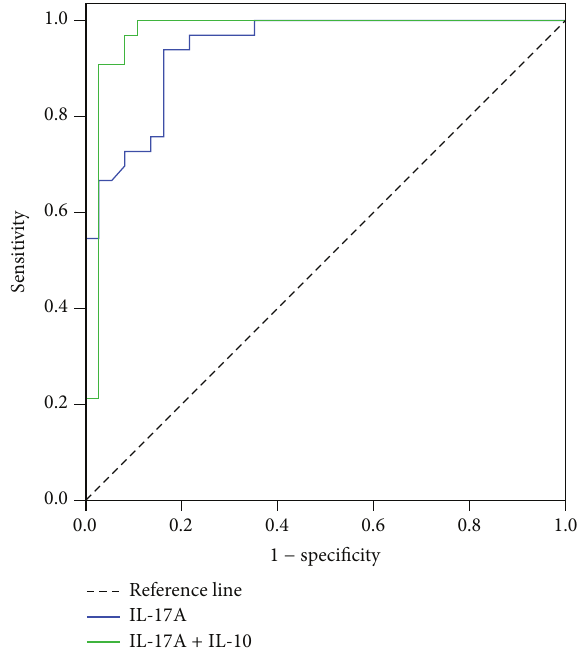
Figure 4: ROC curve analysis of the prediction of HADAS based on the serum IL-17A and combination of serum IL-17A and IL-10 levels. ROC curve analysis showing the performance of the biomarker IL- 17A alone (blue) and a combination of IL-17A and IL-10 (green) in predicting the development of HADAS on the baseline. HADAS = high-altitude deacclimatization syndrome, IL-17A = interleukin- 17A, and IL-10 =